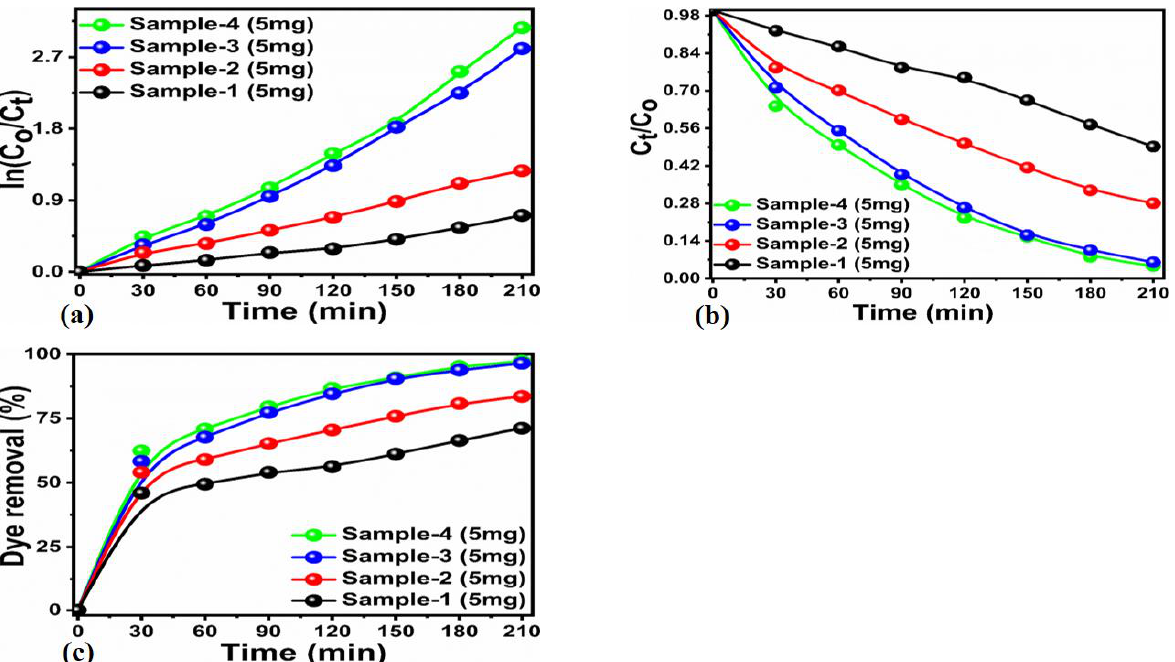
Figure 7. Photodegradation kinetics of 8.22 × 10 −5 M) MB solution with catalyst dose of 5 mg of various samples of ZnO such as sample-1, sample-2, sample-3, and sample-4 under the irradiation of natural sunlight, ( a ) Linear plot of ln( C t / C o ) against corresponding time of 210 min. ( b ) Linear plot of C t /C o . ( c ) Degradation efficiency of MB solution using catalyst dose of 5 mg of sample-1, sample-2, sample-3, and sample-4.